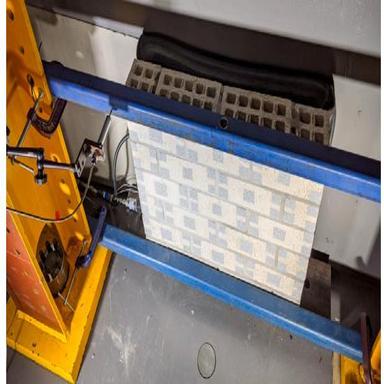
Bending test setup.